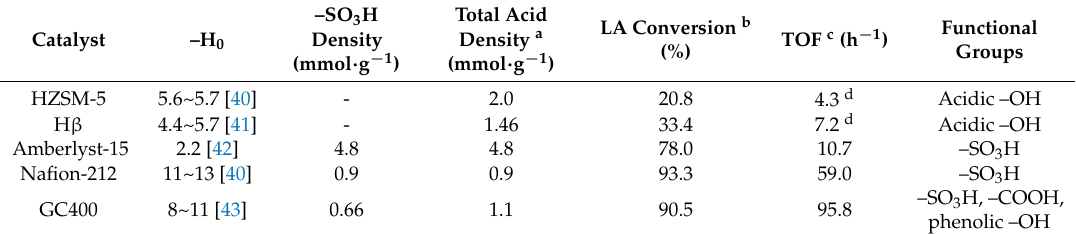
Table 2. Hammett acidy function (–H 0 ) values, acid density and catalytic activity of the solid